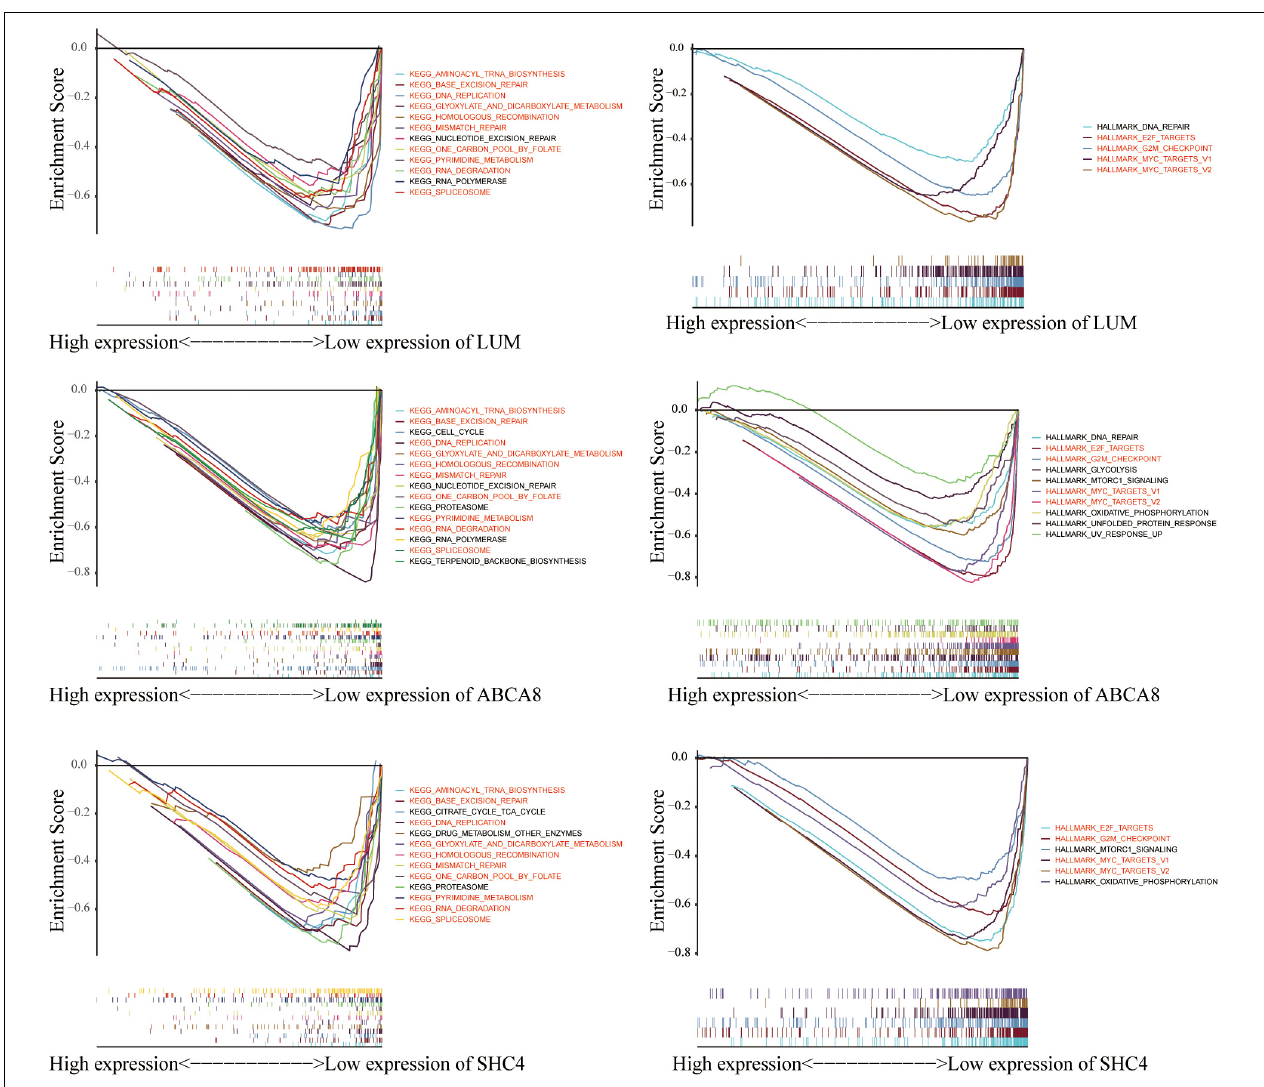
FIGURE 7 | Gene Set Enrichment Analysis (GSEA) of 3 key genes. 10 KEGG pathways and 4 hallmarks were significantly enriched in the low expression of macrophage abundance and 3 key